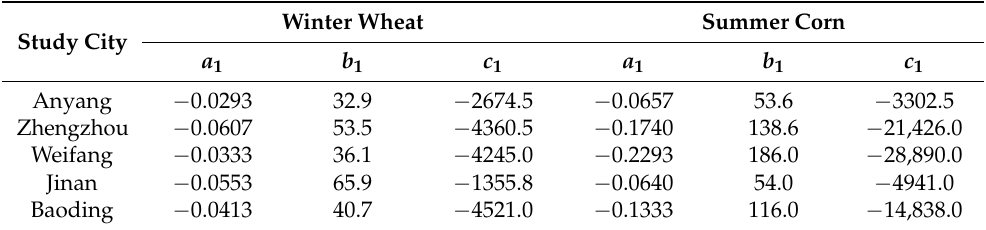
Table 5. Crop water production function coefficients of winter wheat and summer maize in five cities. Study